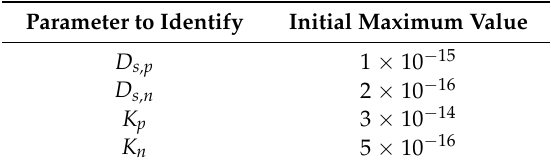
Table 1. Initial values of the parameters to be